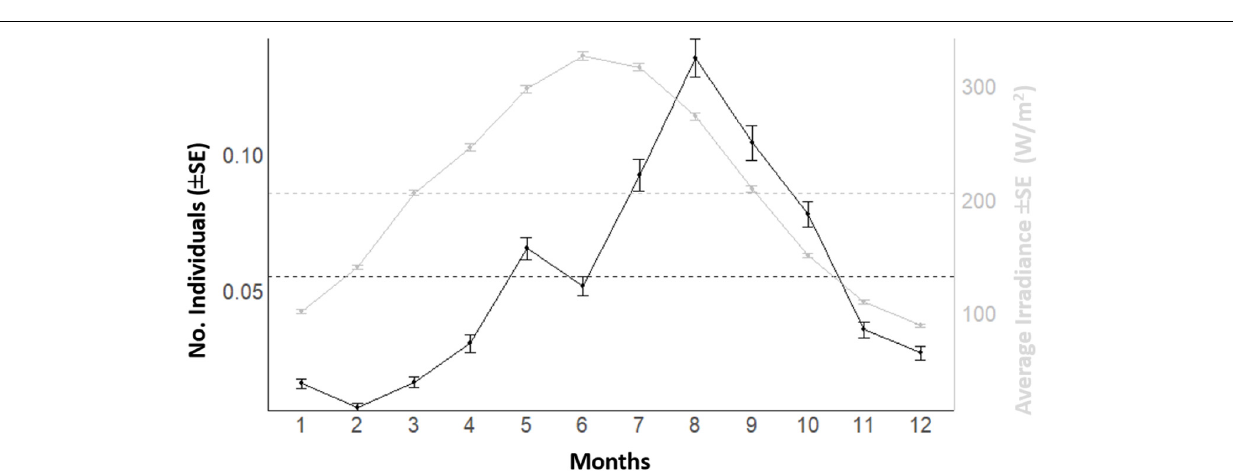
FIGURE 7 | Plot of mean counts ( ± SE) per each month of the year of D. dentex visual counts and solar irradiance recorded during 8 years (i.e., 2012–2019) of observations at the OBSEA. The dashed horizontal line is the